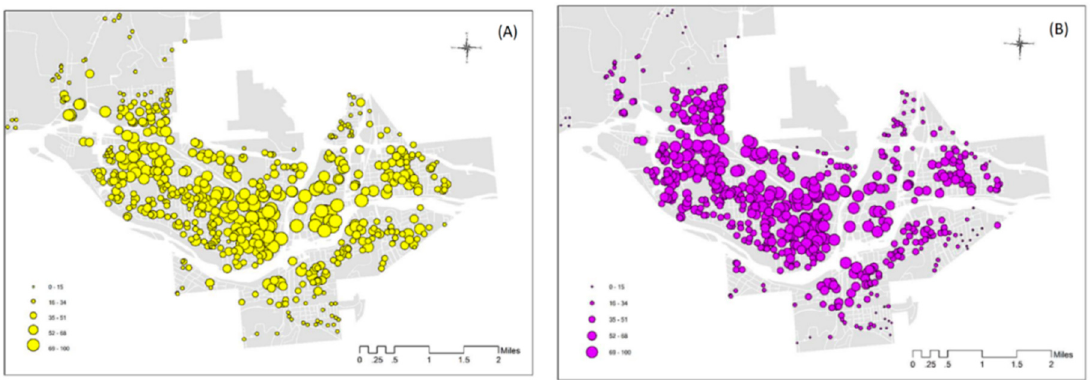
Figure 5. Comparison between two indicators: ( A ) synthetic walkability index; and ( B ) Walk Score with the same random samples at each individual location in Binghamton.